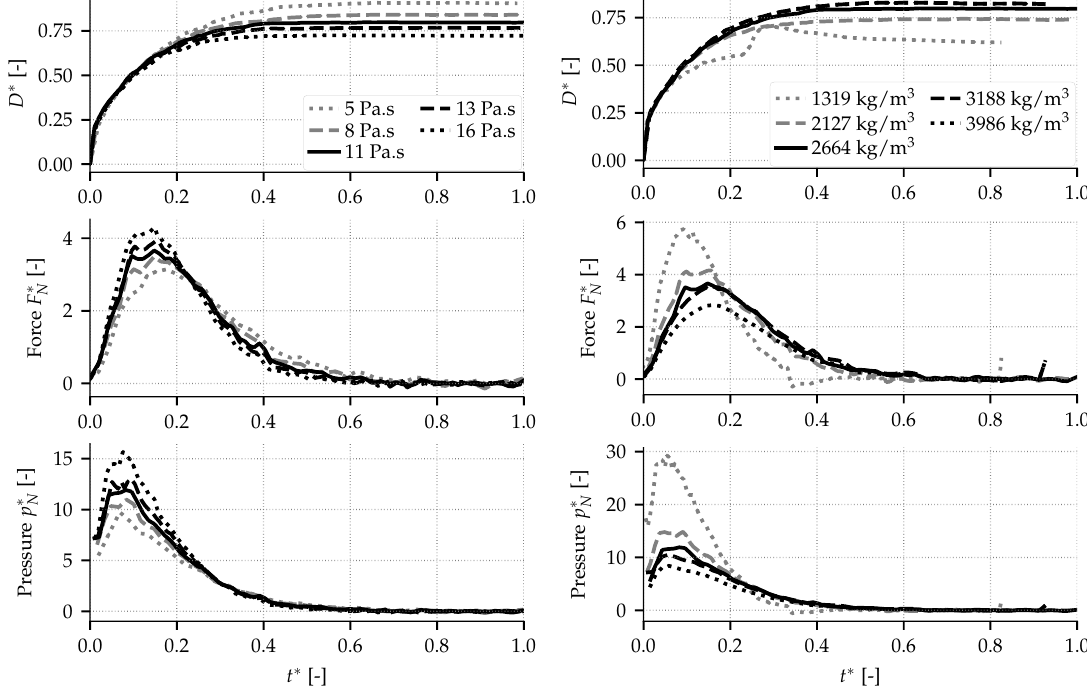
Figure 9. Influence of the sand particle viscosity ( left ) and density ( right ) on the impact transients in the nondimensional spreading diameter ( top ), total normal force ( middle ) and contact pressure ( bottom ) as a function of nondimensional